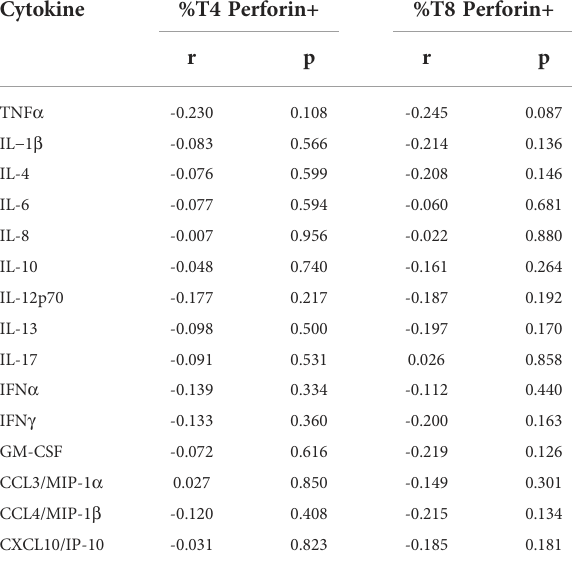
TABLE 2 Absence of correlation between the frequency of perforin- positive T4 cells and T8 cells and the plasma level of 15 biomarkers of COVID-19